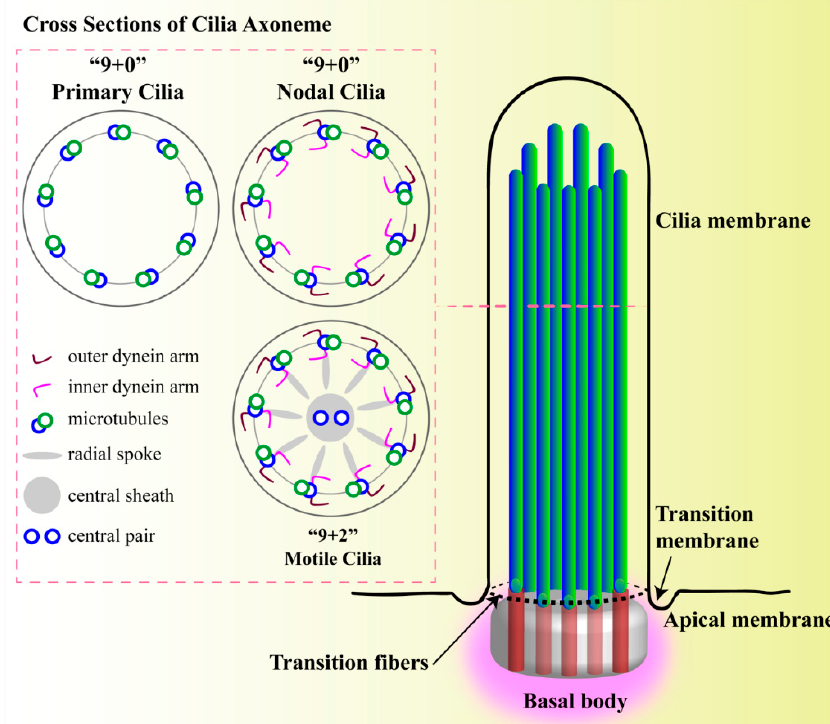
Figure 1. Structure of primary cilium. A cilium is a membrane-bound structure and composed of multiple central pairs of microtubules (axoneme) running from the basal body. A basal body is a microtubule-based structure composed of mother and daughter centrioles. The ciliary membrane and axoneme contributes to the upper part of the cilium. The ciliary membrane is continuous with the cell membrane, but they have their own proteins, ion channels and/or receptors. The ciliary skeleton may have 9 + 0 or 9 + 2 axoneme compositions. Most 9 + 0 cilia lack inner and outer dynein arms, radial spokes, and central sheath and are commonly referred as non-motile primary cilia. Some 9 + 0 cilia lack the central microtubule only and are motile. Between the cell membrane and cilium, there is a transition-membrane at the junction of the basal body acting as a barrier for molecules to enter or exit from the primary cilium.